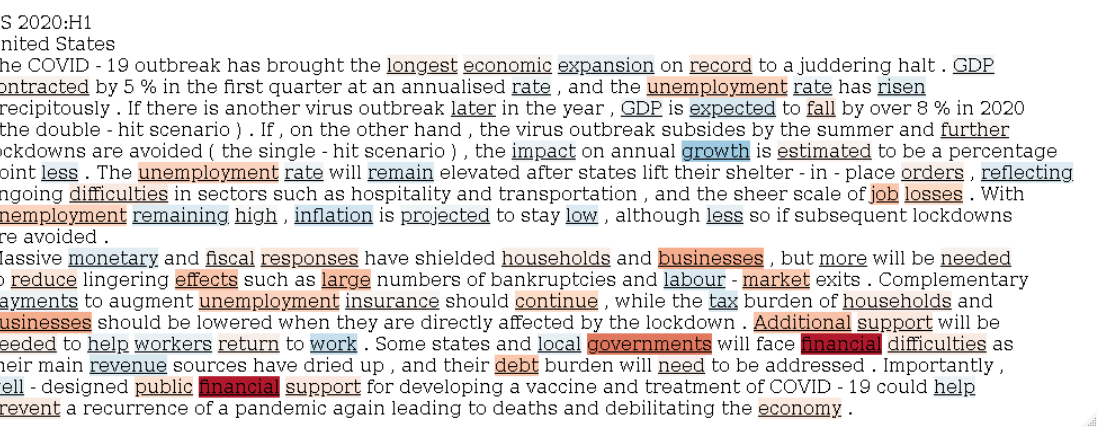
Figure 13. US OECD Economic Outlook with LIME Highlighting for 2020 . Note: This passage shows the OECD Economic Outlook text for the first half of 2020 in the United States shaded according to LIME feature weights. The red words indicate a positive contribution to model output probability that the United States in a Romer 5+ crisis, while blue words indicate a negative contribution; darker shading of a word indicates a higher magnitude of contribution. In other words, darker red words contribute more (and darker blue contribute less) to the probability of the machine learning algorithm indicating that the United States is in a financial crisis. Underlined terms are those in the OECD dictionary. The words “government”, “financial”, and “unemployment” are shaded in red, implying that these terms help to signal that the United States is in a crisis. These results are based on the SVM Radial model trained on OECD text from 1981–2004 predicting Romer 5+